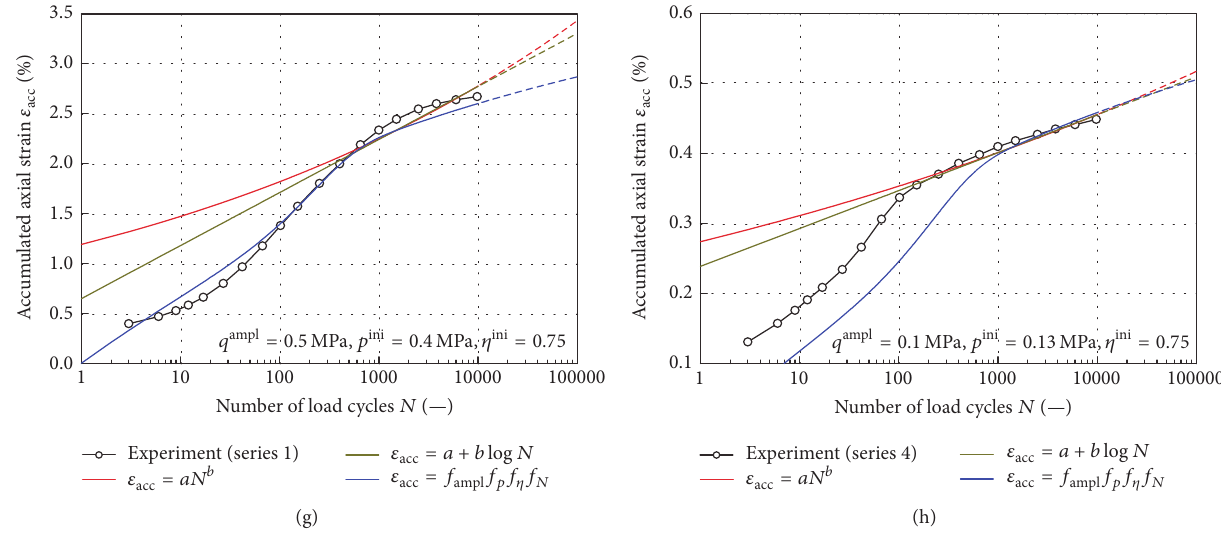
Figure 16: Comparison of the calculated and measured accumulated axial strain.